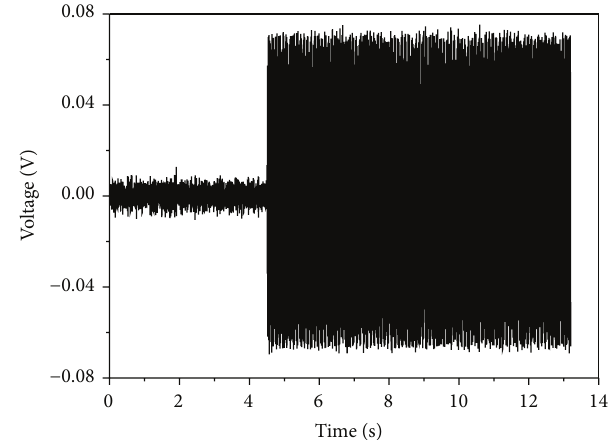
Figure 8: Change of self-induced voltage from position 1 to position 2.